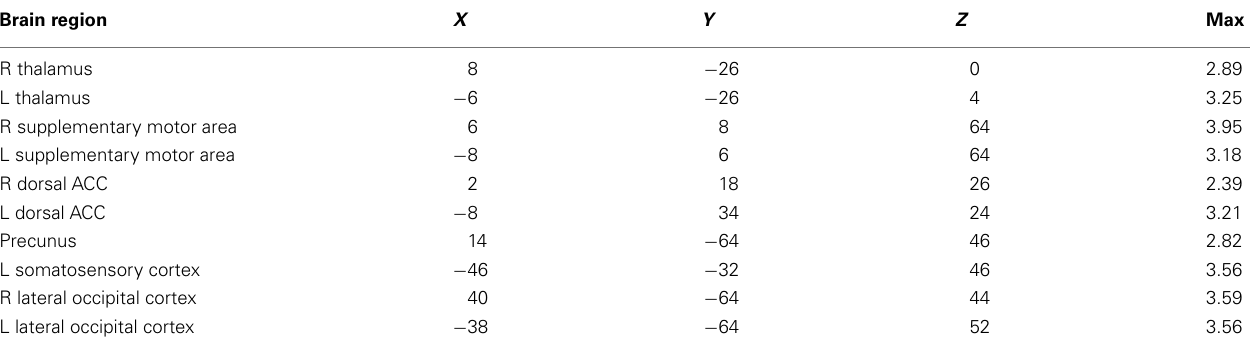
TableA3 | Spatial overlap map of clusters of activation that survived, within each participant’s native space, both the threshold for the awareness contrast and the threshold for parametricTTI effects during target